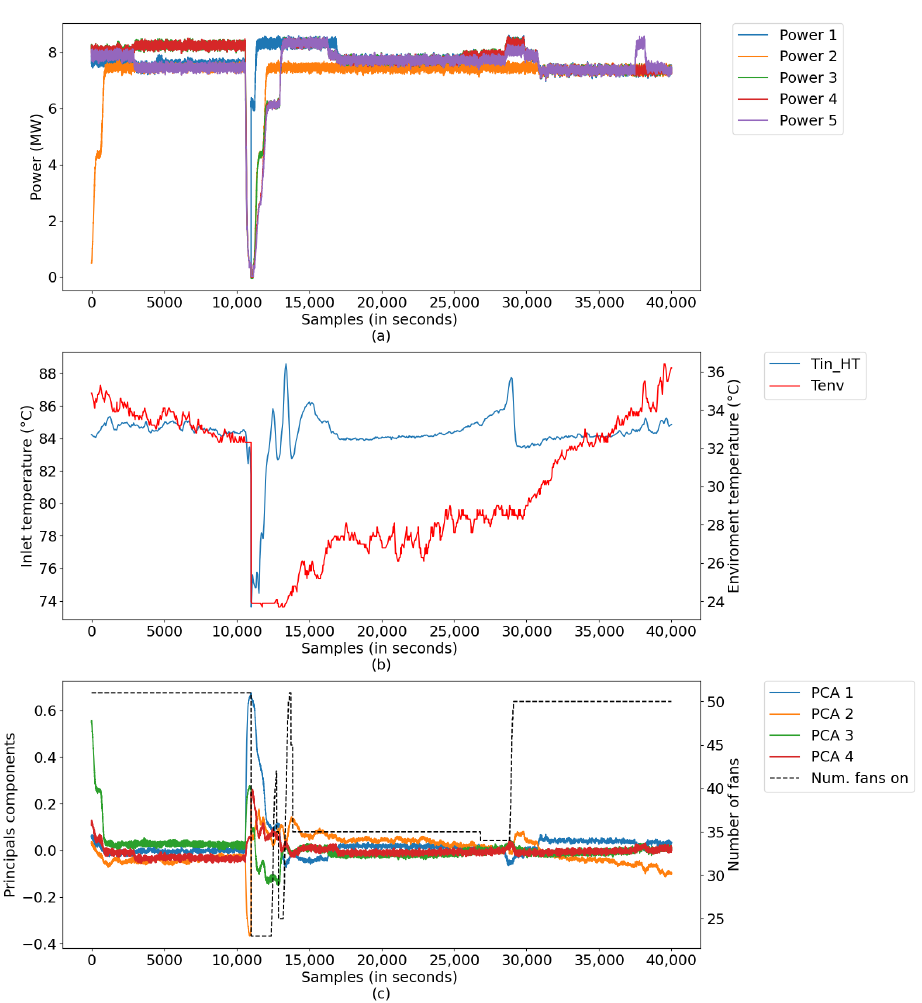
Figure 17. Process inputs: ( a ) powers of DGs; ( b ) T in _ HT and environmental temp , and ( c ) reduced inputs and NumFanOn .